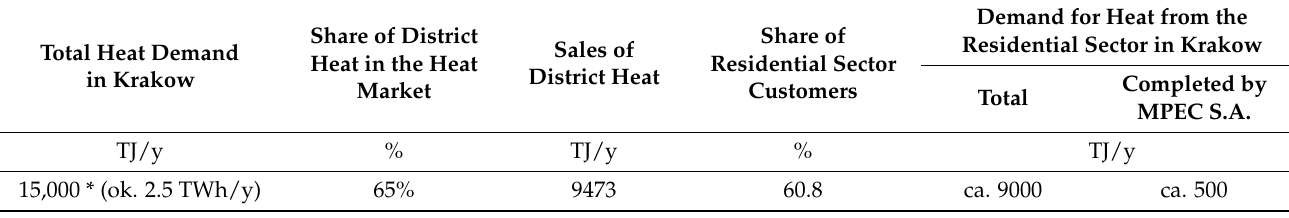
Table 2. Basic parameters of the heat market in Krakow (compiled on the basis of [30], adapted with permission from ref. [30]. Copyright 2021 MPEC